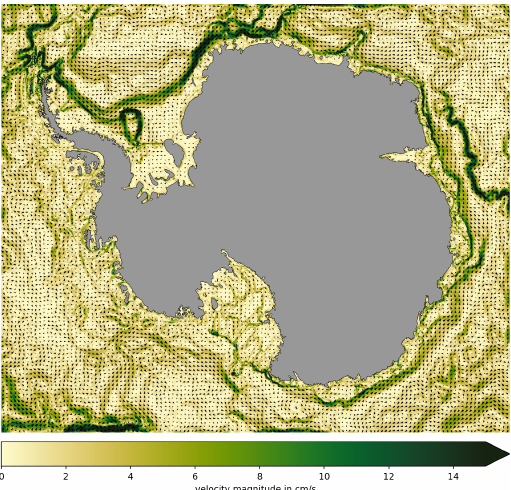
Figure D3. Mean barotropic currents in WAOM. Colours denote 2007 mean barotropic current velocity magnitude, and arrows indicate direction. WAOM reproduces known features, such as the southern limb of the ACC around the Kerguelen Plateau, the southern limbs of the Ross and Weddell Sea Gyres, the slope current (e.g. around East Antarctica), and coastal currents (apparent in e.g. Prydz Bay and in front of the Totten Ice Shelf). However, some boundary effects are apparent in the eastern Ross